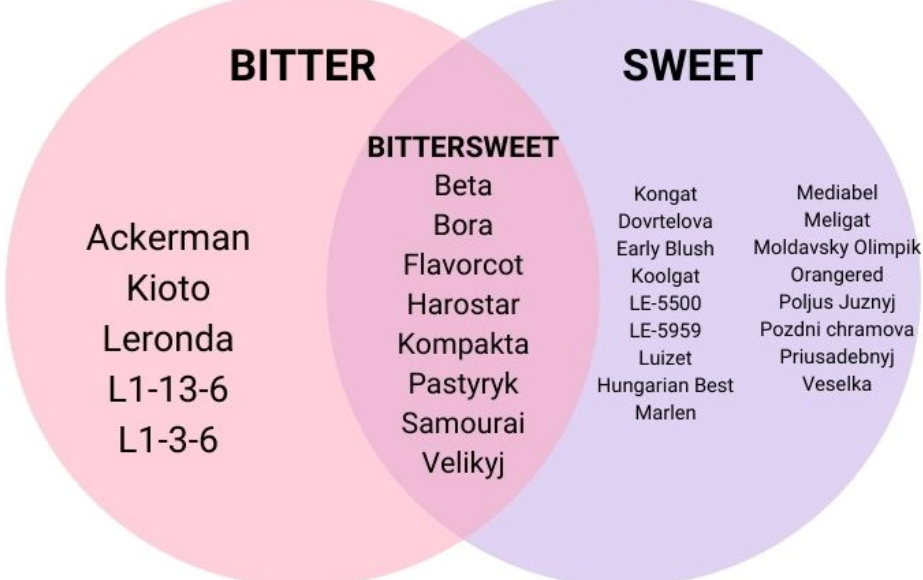
Figure 4. Variation of apricots cultivars based on taste